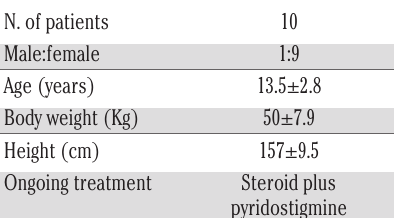
Table 2. Patients’ characteristics.